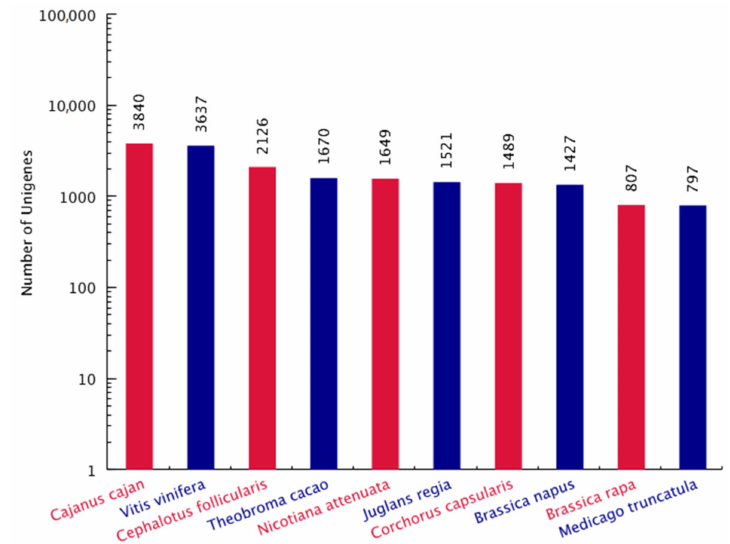
Figure 5. Top 10 species distribution of unigenes against Nr database. A total of 16,921 DEGs were identified in the CR compared with CS, with 6580 genes up-regulated (UR) and 10,341 genes down-regulated (DR) (Figure 6). Of these 16,921 DEGs, 2684 genes were identified to match with the databases (Figure 7A). Among the 2684 genes, 2573 genes with known functions were partitioned into 1725 UR and 848 DR (Figure 7B,C).